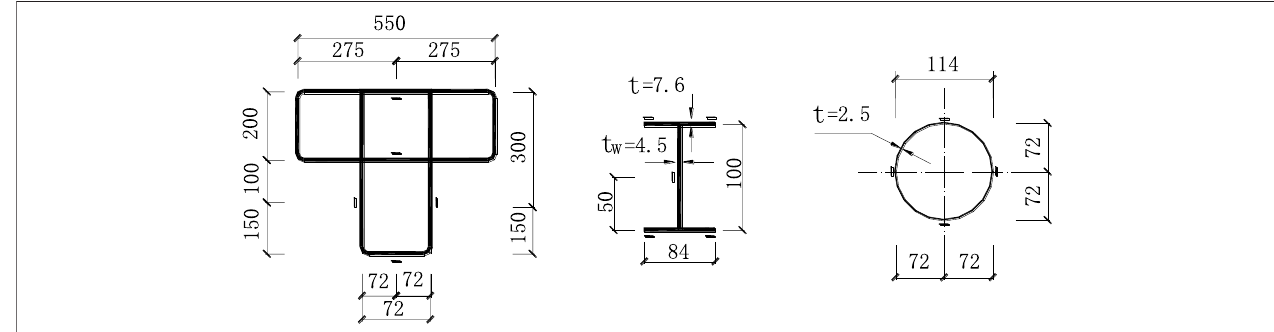
FIGURE 17 | Distribution of strain gauges of stirrups shape steel and tube (Xiang et al., 2017; Xiang et al., 2019).